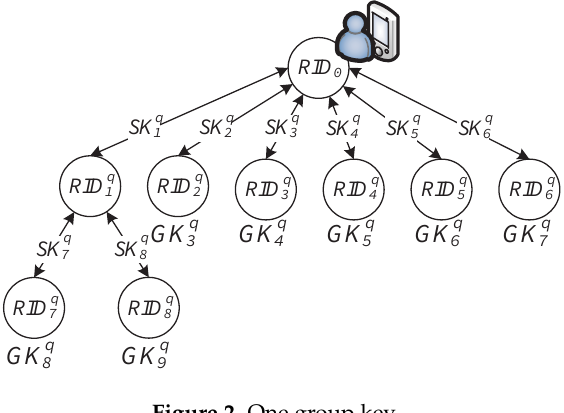
Figure 2. One group